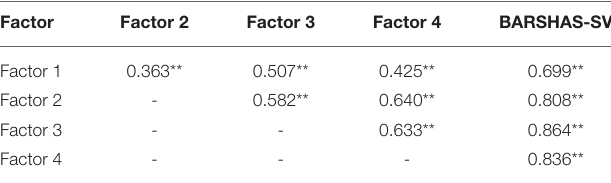
TABLE 5 | Correlation coefficients among four factors of the BARSHAS-SV and between different factors and the whole BARSHAS-SV. Factor